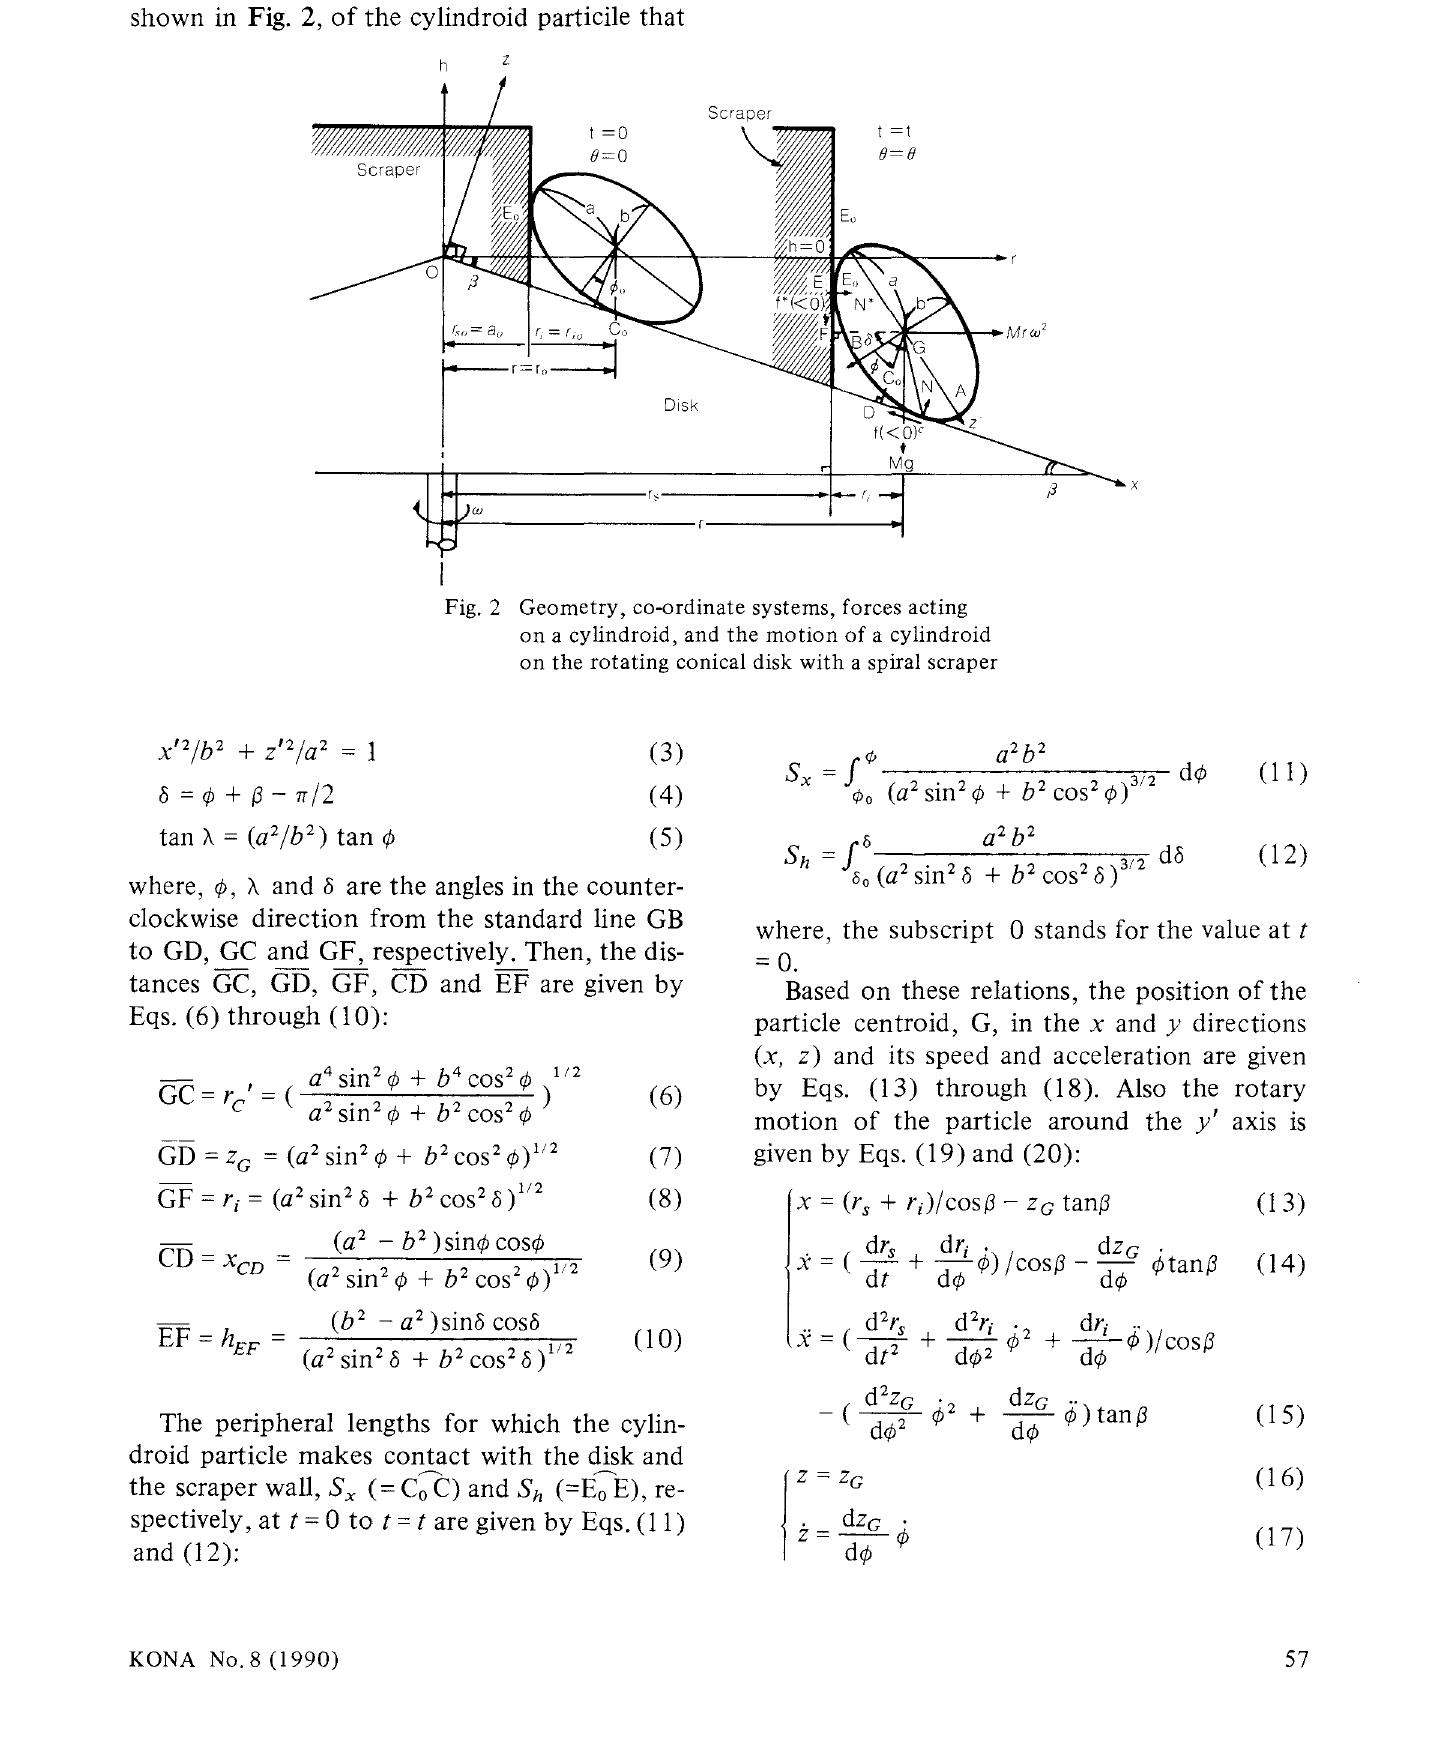
Fig. 2 Geometry, co-ordinate systems, forces acting on a cylindroid, and the motion of a cylindroid on the rotating conical disk with a spiral